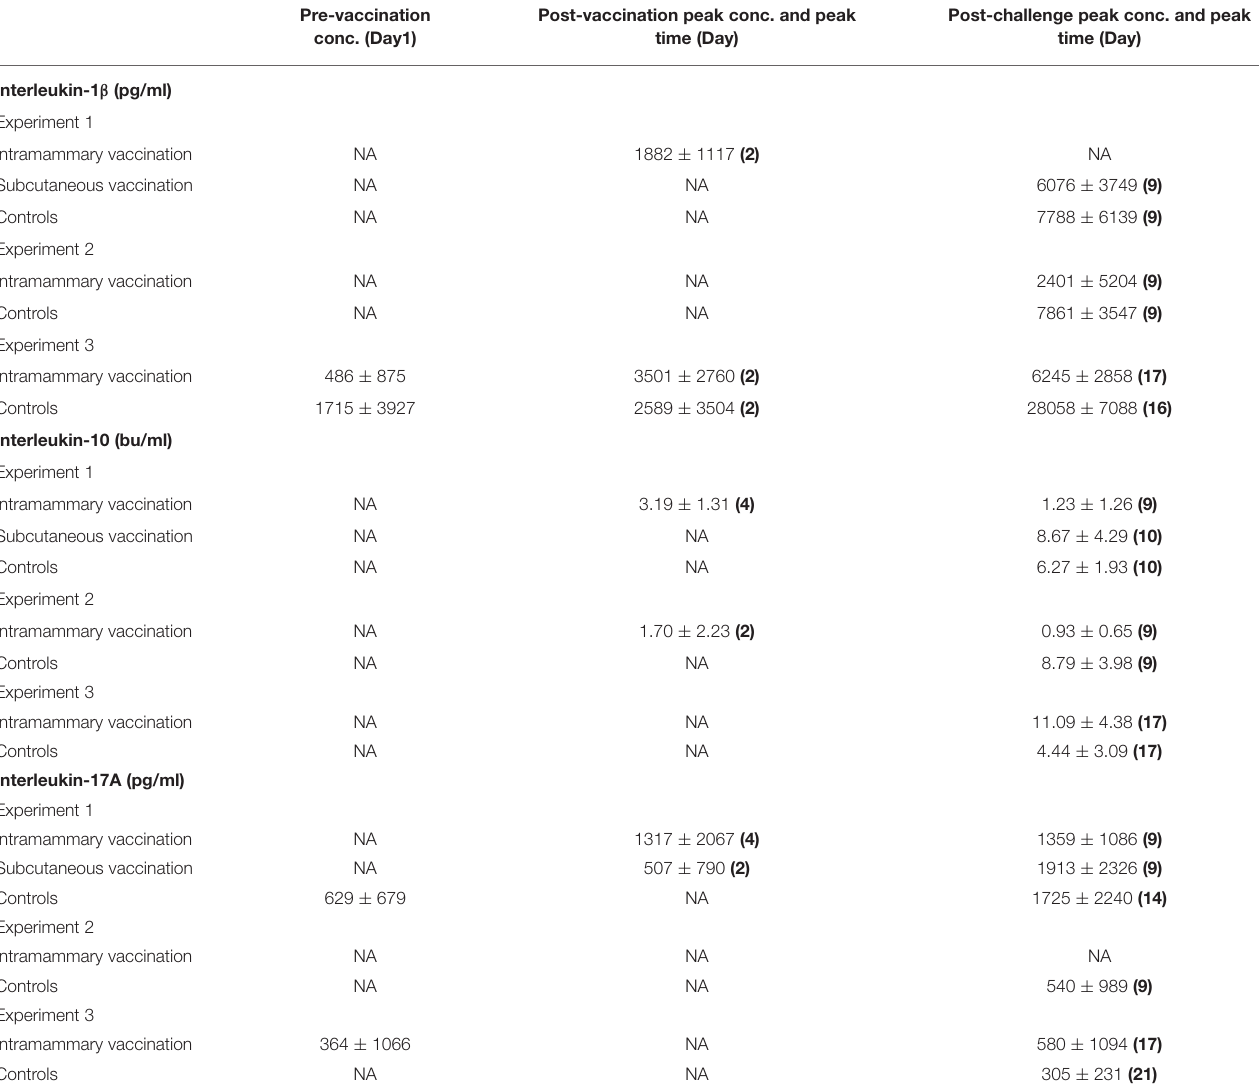
TABLE 2 | Concentration of milk cytokines above the baseline pre-vaccination, post-vaccination peak, and post-challenge peak.